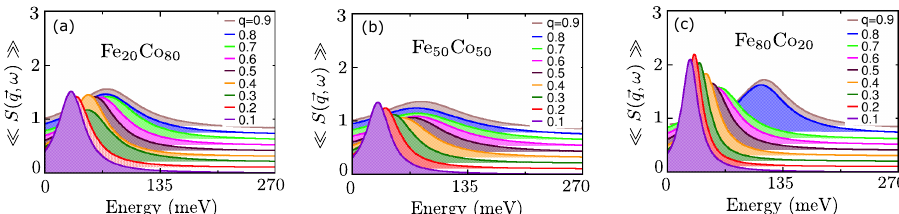
Figure 1. The dynamical structure factors (cid:28) S ( (cid:126) q , ω ) (cid:29) for a selection of wave vectors (cid:126) q , varying from 0.1 to 0.9 along the symmetric Γ − H direction in the Brillouin zone of bcc Fe x Co 1 − x alloys with ( a ) x = 0.2, ( b ) x = 0.5 and ( c ) x = 0.8, respectively. In order to identify the peak position, the dynamical structure function (cid:28) S ( (cid:126) q , ω ) (cid:29) was convoluted with a Lorentzian function, normalized to